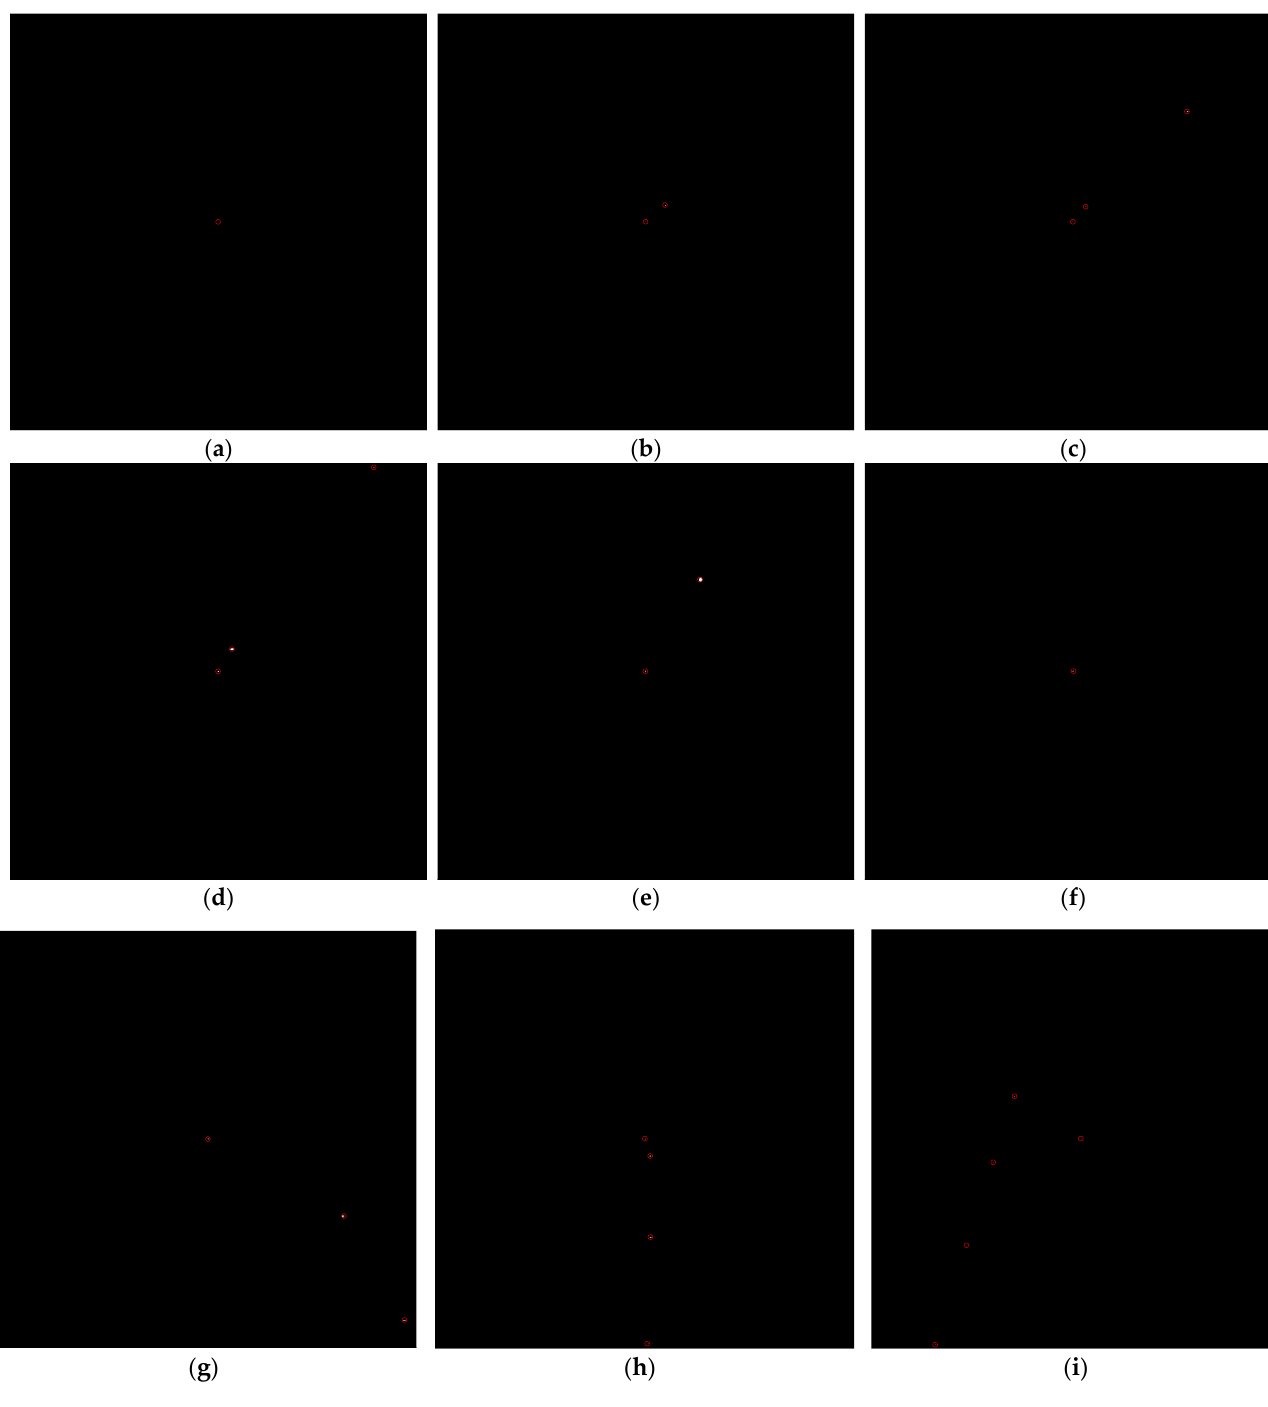
Figure 10. real trajectory of each target in the infrared image.